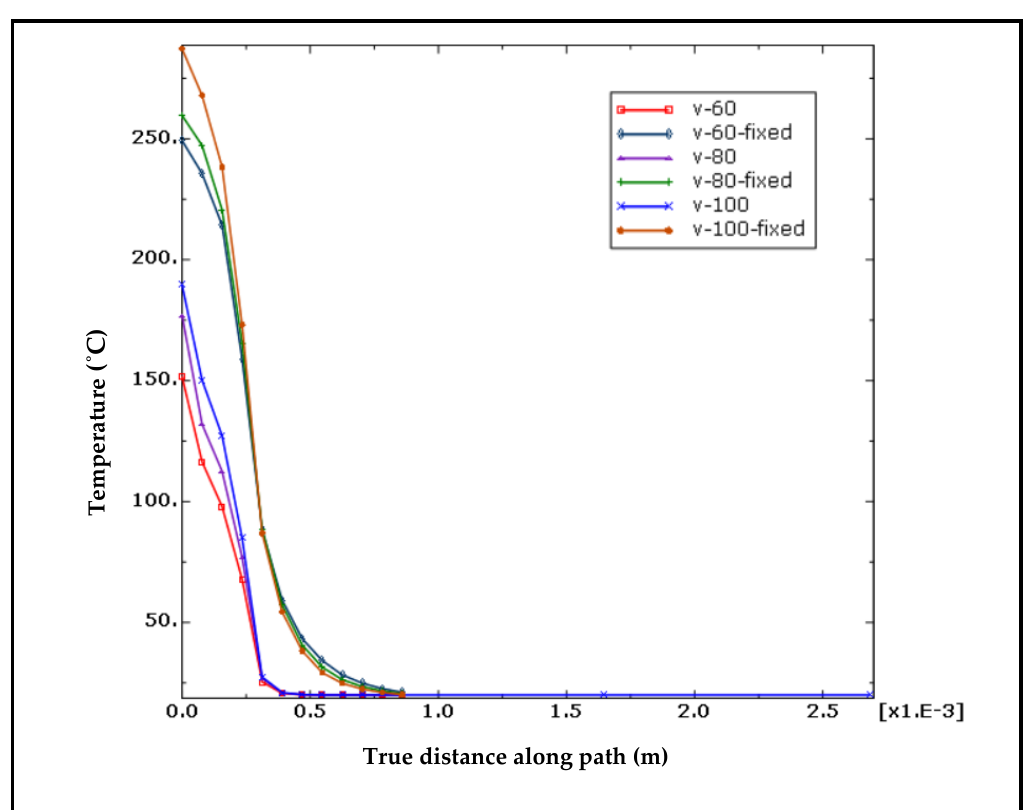
Figure 8. Temperature profiles at the tool cutting edge for different cutting speeds of the fixed and rotating tool.